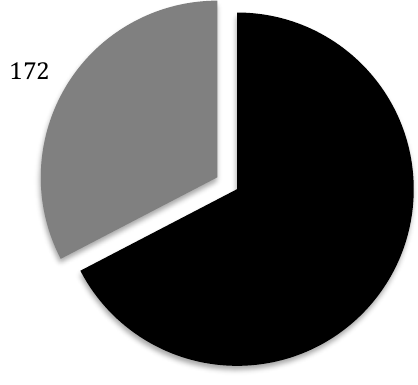
Figure 4: Training in the use of the